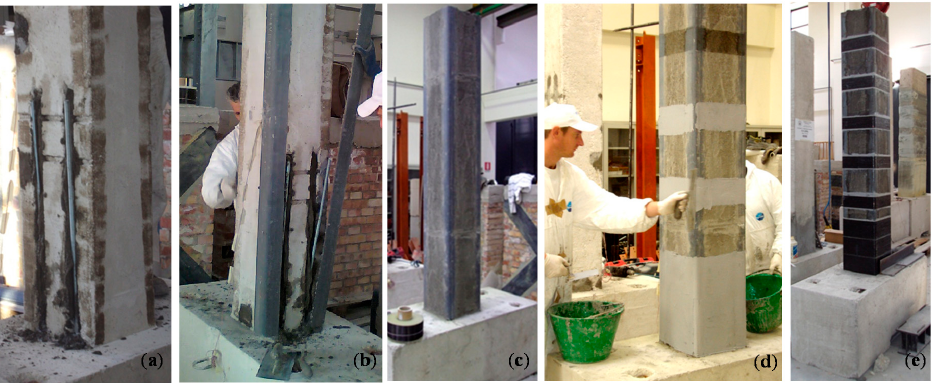
Figure 4. Strengthening procedure: layout “type B”.